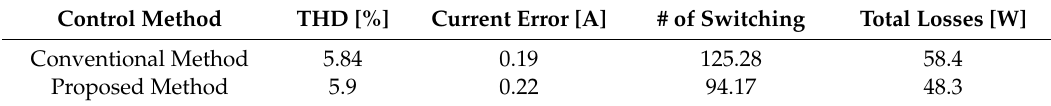
Table 2. Performance comparison between the conventional method and the proposed